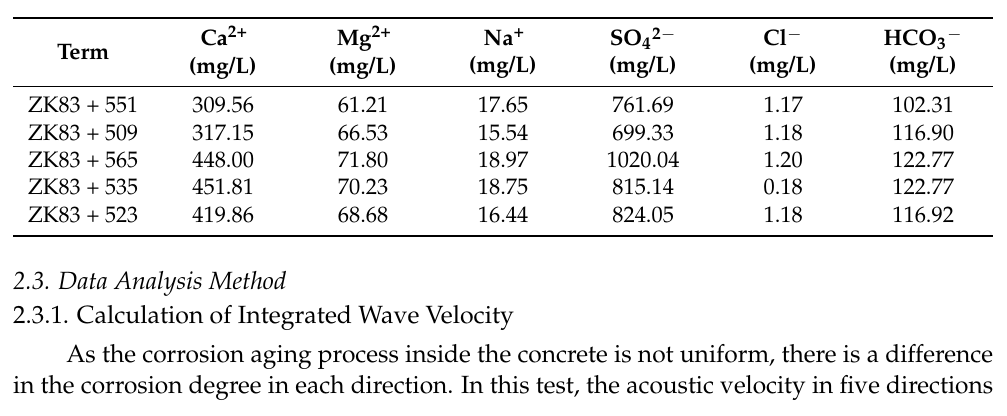
Table 2. Detection groundwater ion water samples at concrete borehole of